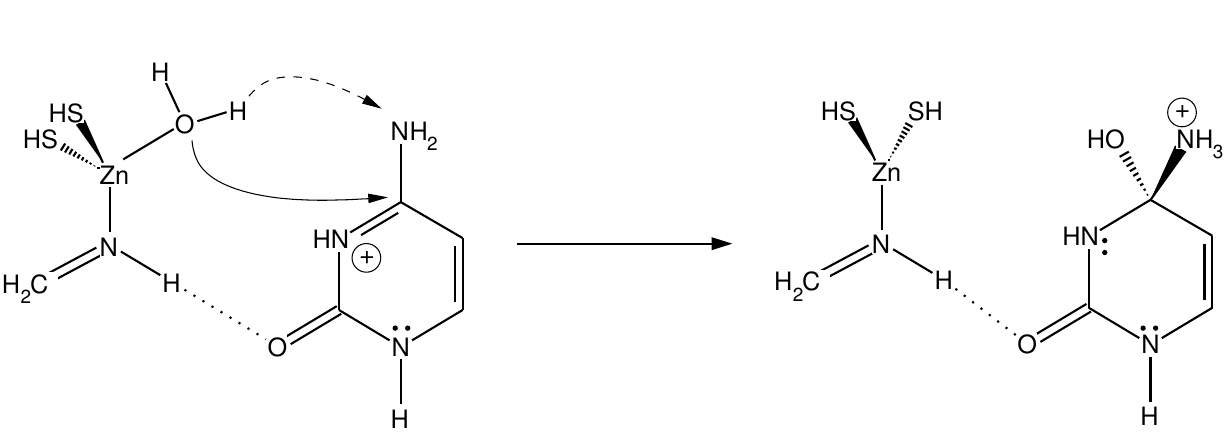
Figure 2: Model of the slowest step of the deamination reaction performed by cytidine deaminase – nucleophilic attack of water molecule on the C4 atom of the N3-protonated cytidine. on the grid points. The grid was generated on the inner surface of the active site model using a method by Connolly [17] and the point density of 4/Å 2